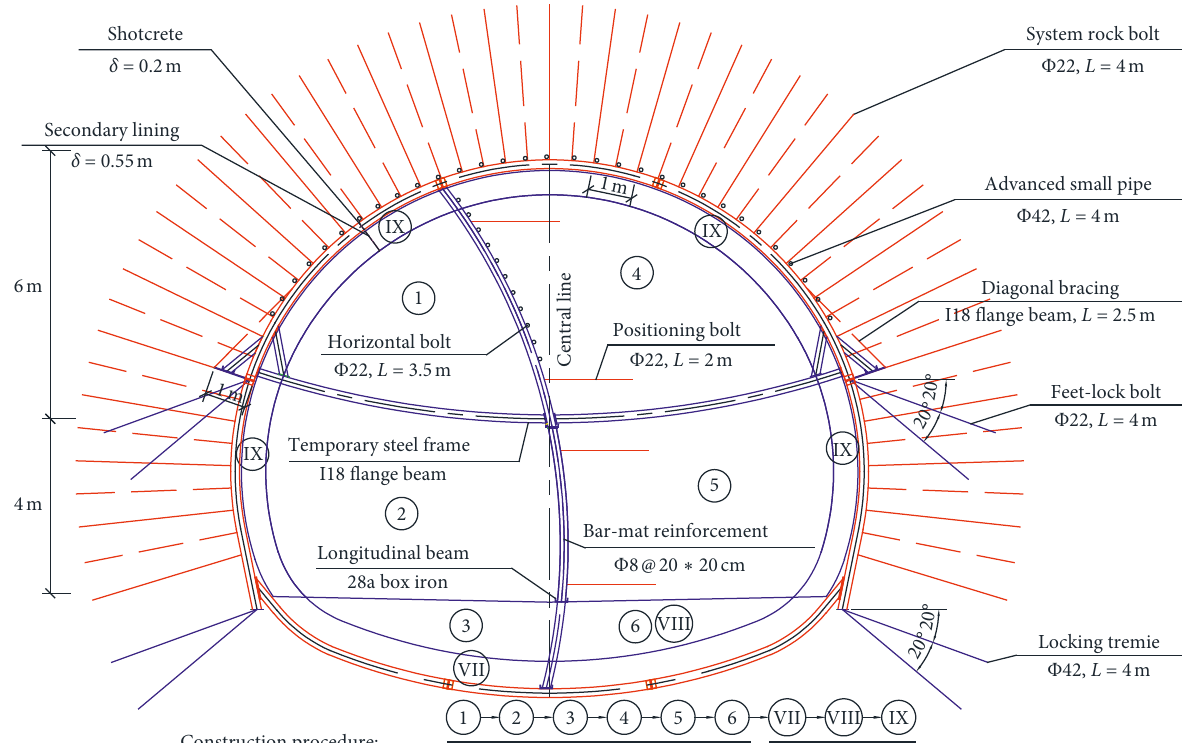
Figure 3: Construction procedure and supporting